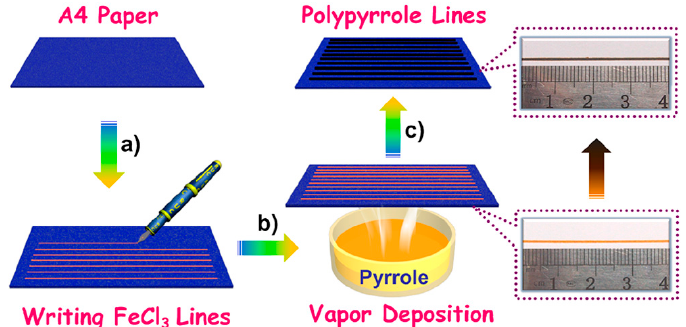
Figure 2. Schematic illustration of pen-writing PPy on A4 paper: ( a ) pen-writing FeCl 3 solution on the paper; ( b ) Exposing the FeCl 3 lines to Py vapor; ( c ) Interfacial polymerization of Py along the FeCl 3 lines. Insets are photographs of A4 paper written with FeCl 3 and PPy after fumigation. Reprinted with